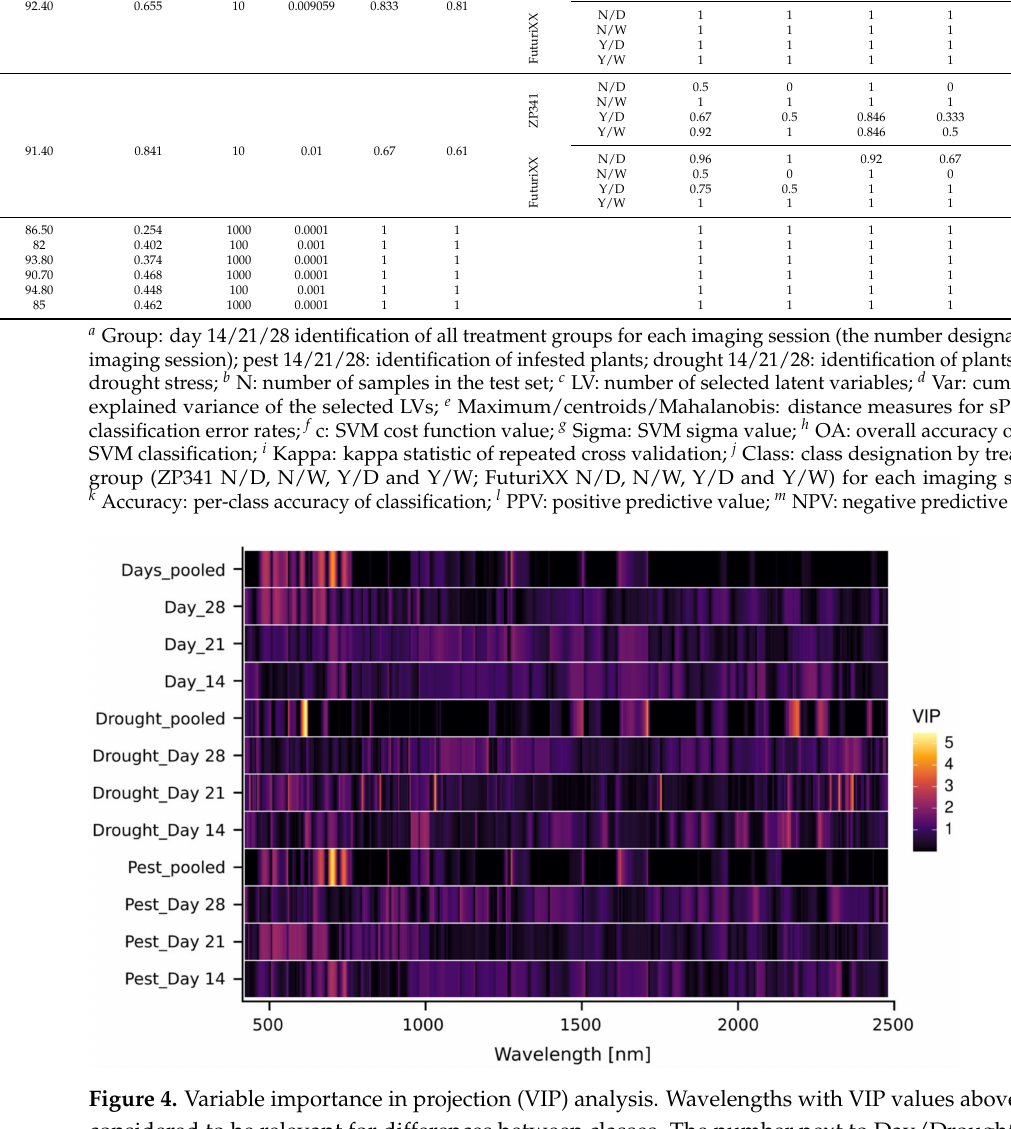
Figure 4. Variable importance in projection (VIP) analysis. Wavelengths with VIP values above 1 are considered to be relevant for differences between classes. The number next to Day/Drought/Pest indicates the imaging session (i.e., day 14, 21 or 28 after adding wireworms and changing the watering